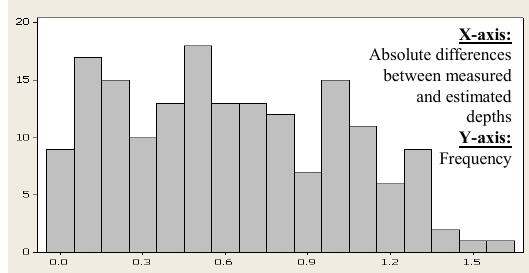
Figure 3. The histogramme of absolute differences between measured and estimated depths (area A). 74% of the differences are under 1.0 m